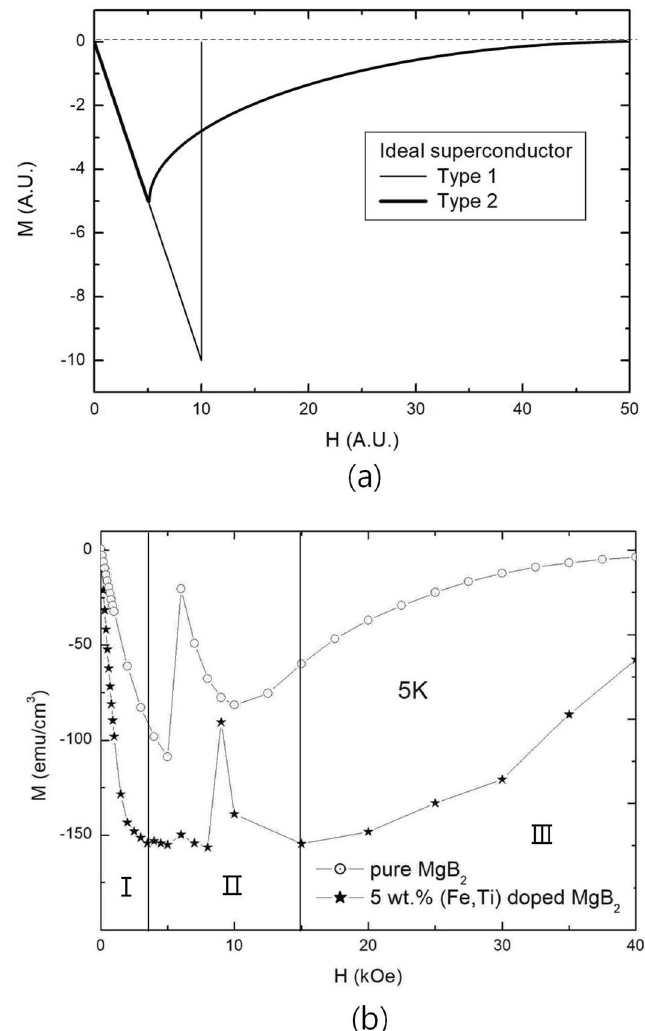
Figure 1. Field dependences of magnetizations (M-H curves) of superconductors ( a ): M-H curves of ideal type I and type II superconductors ( b ): M-H curve of 5 wt.% (Fe, Ti) particle-doped MgB 2 at 5 K, which is volume defect-dominating superconductor. It can be divided as three discreet region, which is diamagnetic increase region (Region I), (cid:31) H = (cid:31) B region (Region II), diamagnetic decrease region (Region III). M-H curve of pure MgB 2 at 5 K is used as a